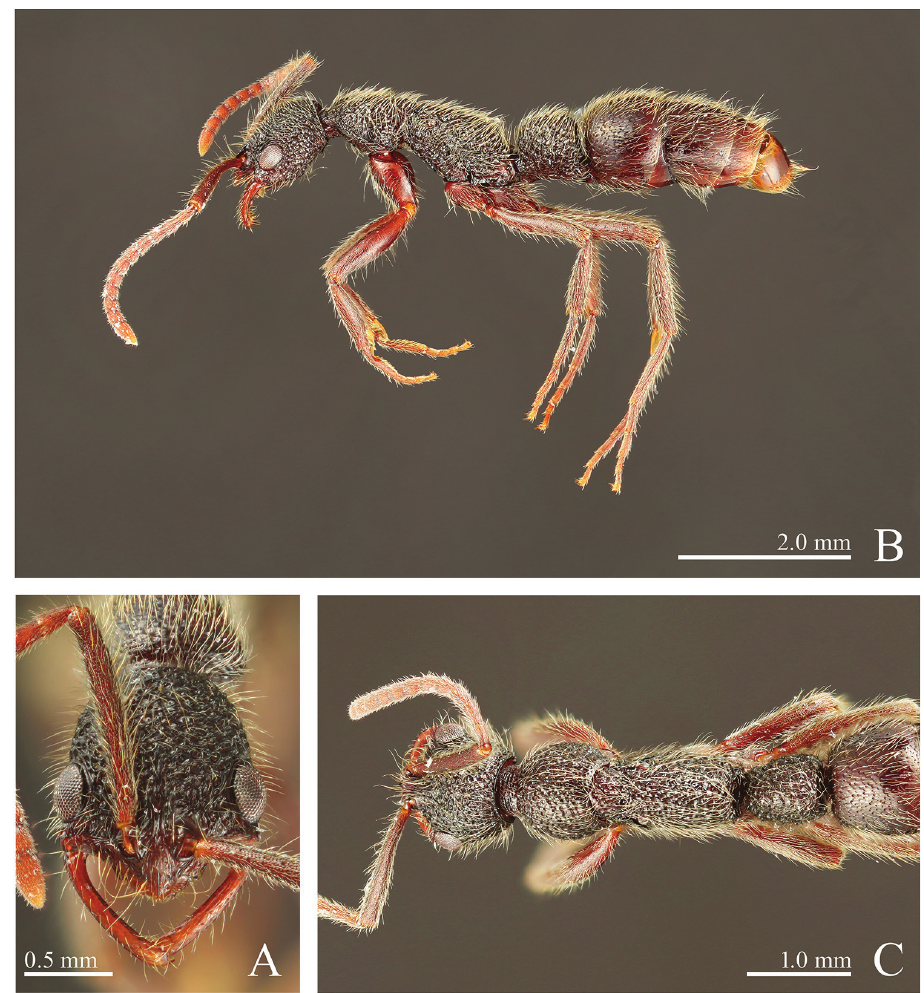
Figure 5. Leptogenys breviloba sp. n., paratype, queen; gastral apical segments removed. A head, full-face view B lateral view C dorsal